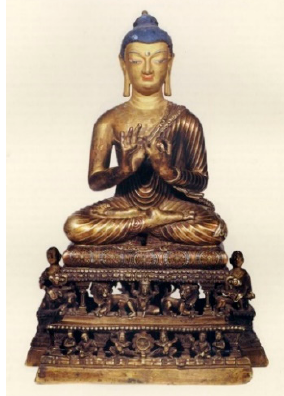
Figure 35. Vairocana Buddha performing the dharmacakra-pravartana mudr ā . Approx. 675–722 C.E. Kashmir or Gilgit. Brass with copper and silver inlay. 30.3 cm H. Po ta la Collection: Li ma lha khang: inventory no. 1383. Red Palace, Lhasa, Tibet. https://himalayanbuddhistart.wordpress.com/category/ all/gilgit/#jp-carousel-178.